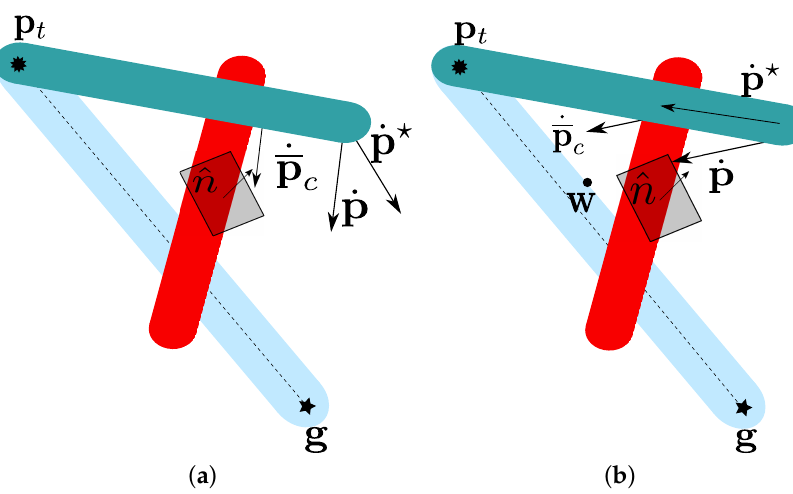
Figure 3. In red: an obstacle. In blue: the tool. In light-blue: the goal pose. Case ( a ) shows that